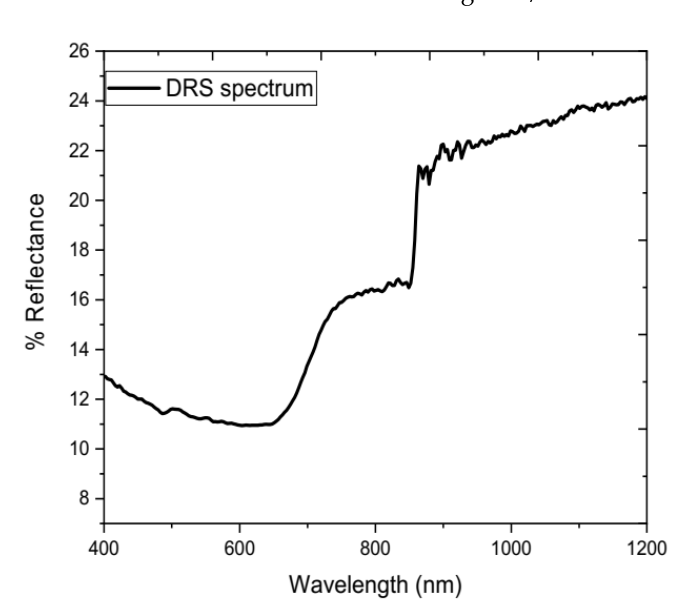
Figure 4. DRS spectrum of green synthesized NiO